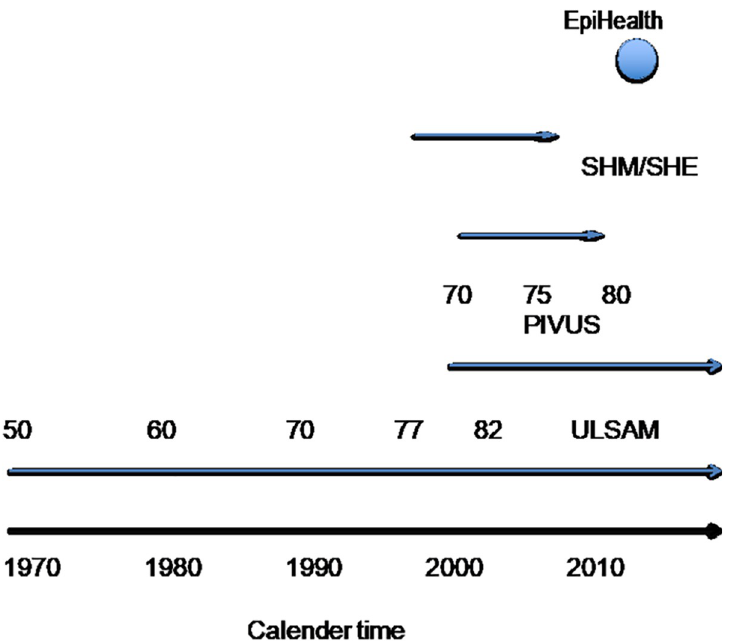
Fig 1. Overview of the different studies in relation to calendar